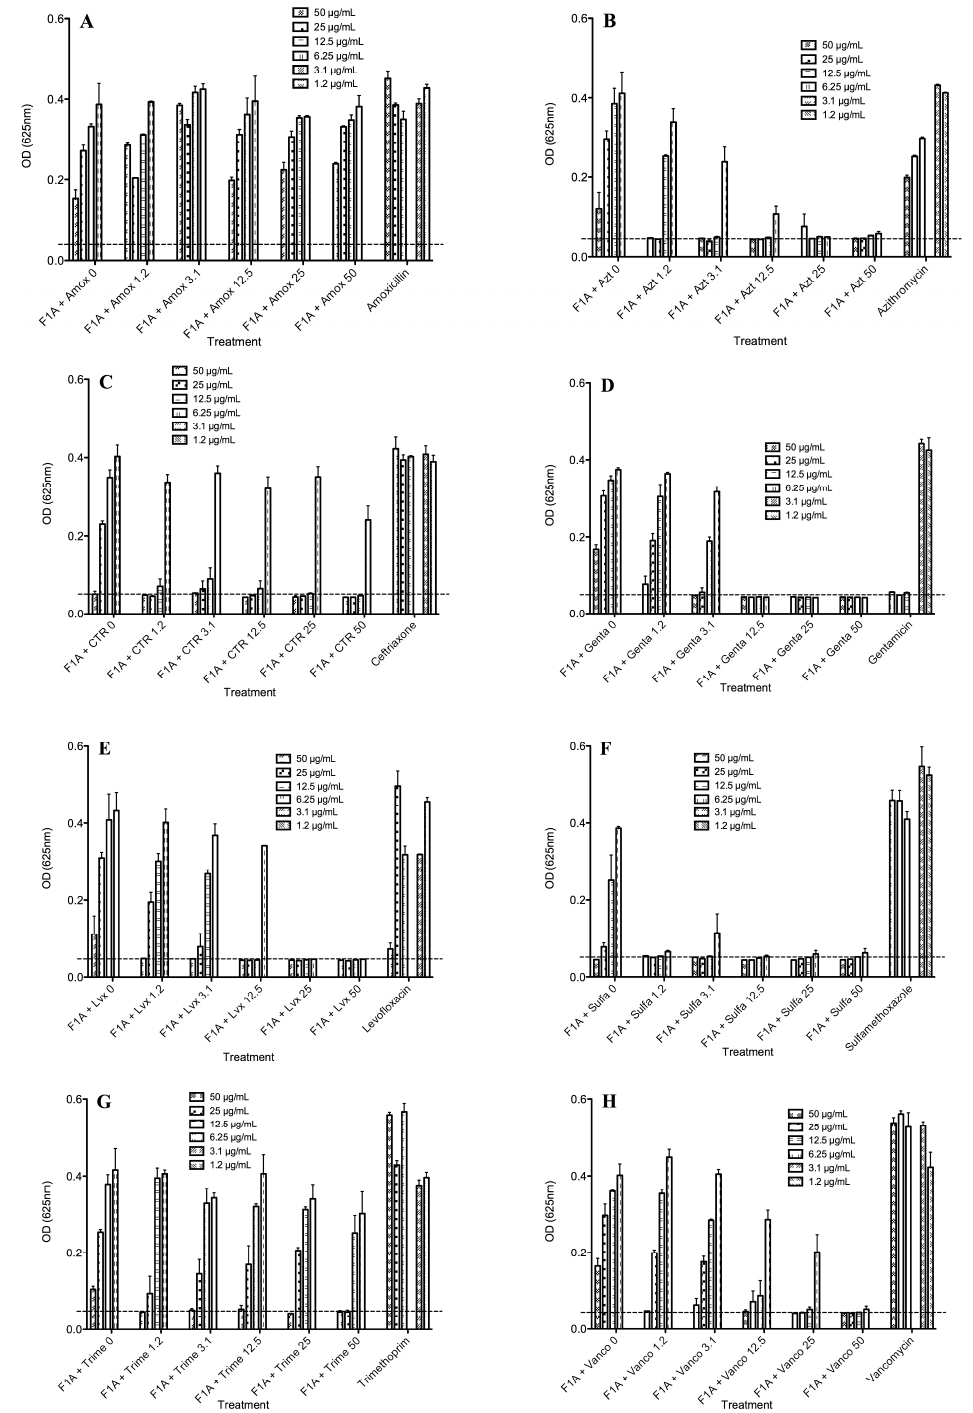
Figure 4. Antimicrobial activity of FA1 in the presence of eight different commercial antibiotics against K. pneumoniae . ( A ) Amoxicillin; ( B ) Azithromycin; ( C ) Ceftriaxone; ( D ) Gentamicin; ( E ) Levofloxacin; ( F ) Sulfamethoxazole; ( G ) Trimethoprim and ( H ) Vancomycin. Bacteria-free well absorbances are indicated by a dotted line.